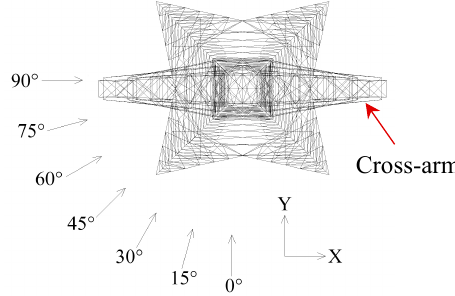
Figure 13. Wind direction angles in wind tunnel test.